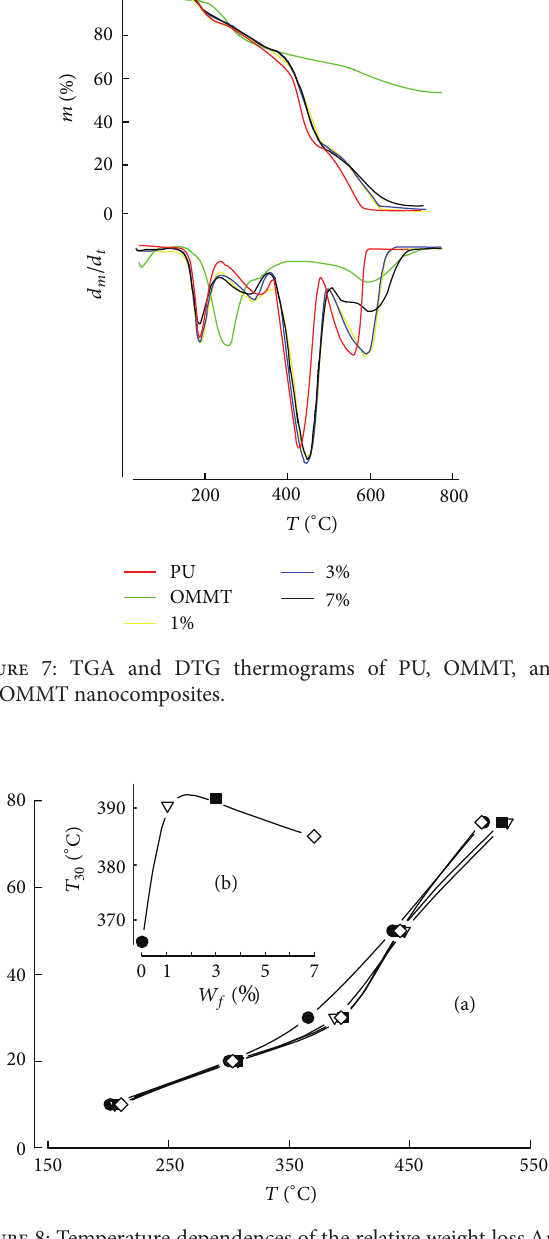
Figure 8: Temperature dependences of the relative weight loss Δ m of PU ( ∙ ) and nanocomposites with 𝑊 𝑓 = 1 ( ∇ ), 3 ( ◼ ), and 7 ( ◊ ) wt.% (a); T 30 % as a function of 𝑊 𝑓